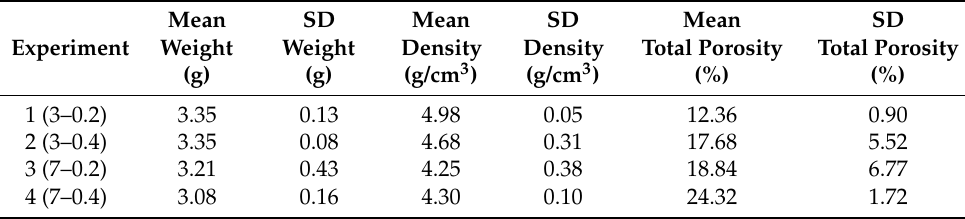
Table 4. Density and total porosity of the printed samples. SD is the standard deviation.